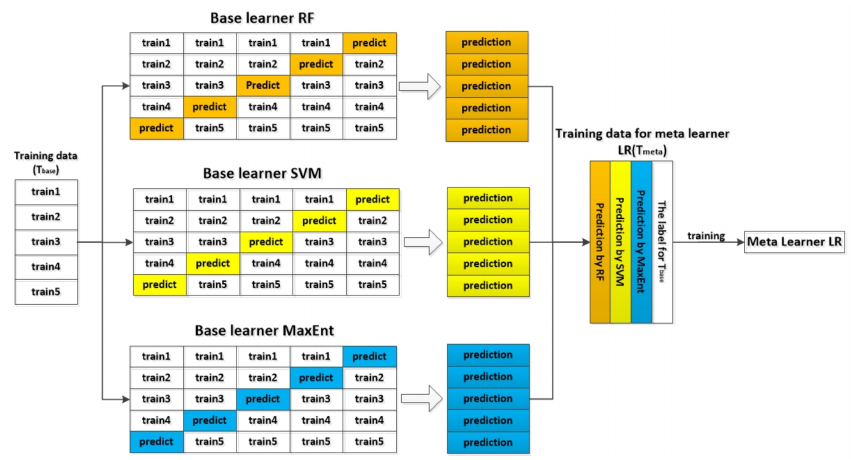
Figure 6. The training process of stacking ensemble learning method